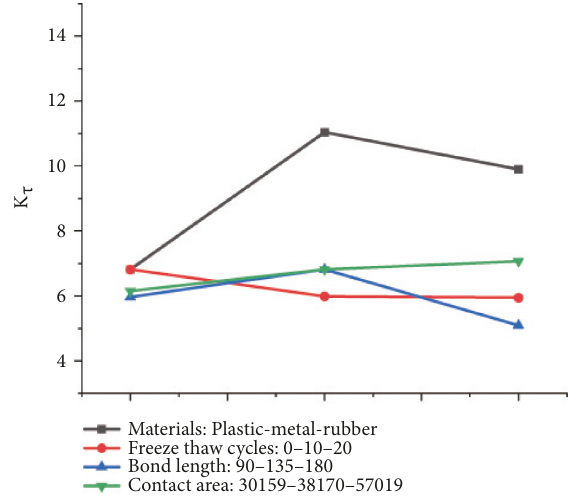
Figure 11: Stiffness ( k